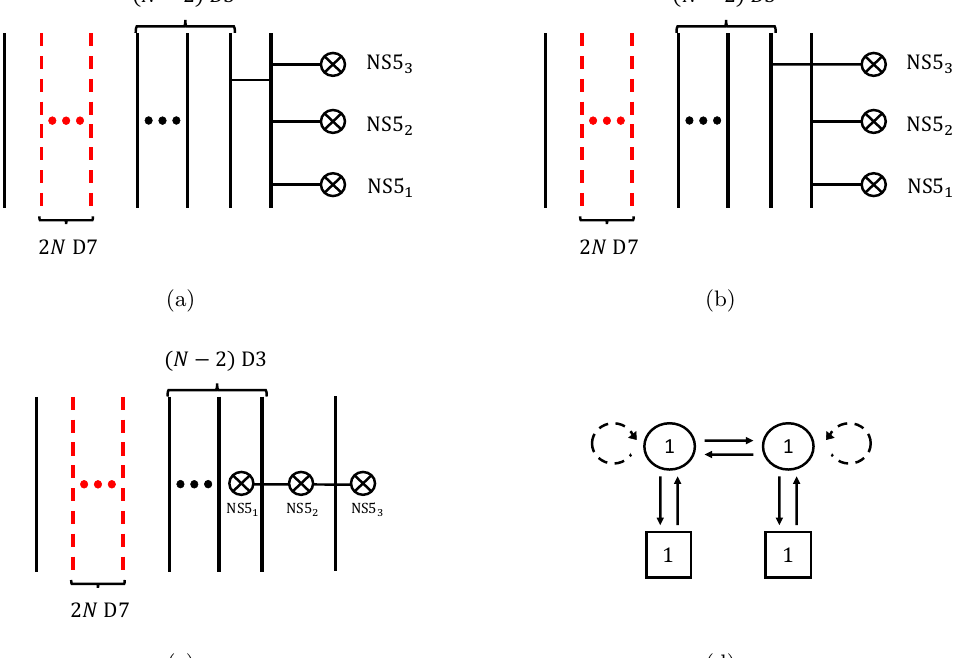
Figure 11 . (a) An introduction of a smooth monopole with magnetic charge e N (cid:0) 1 (cid:0) e N to (cid:12)gure